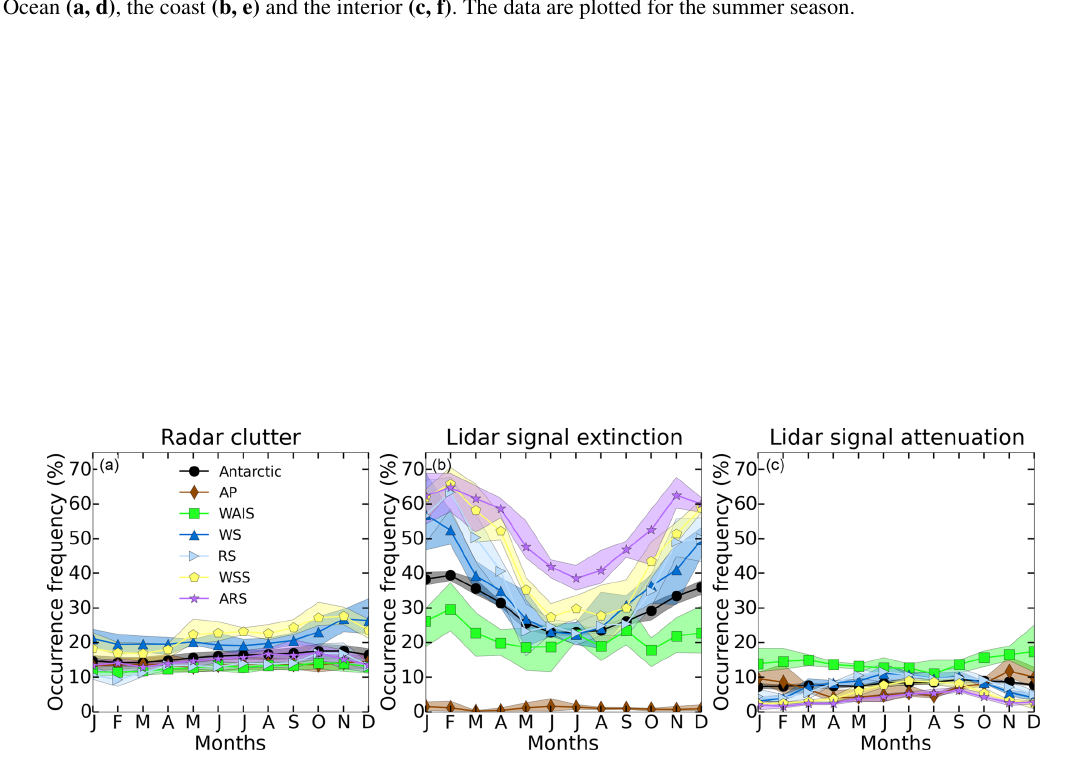
Figure A2. Monthly time series of the low-level occurrences of the radar clutter (a) , the lidar extinctions (b) and the lidar attenuations (c) for the areas defined in Fig. 4c and averaged over 2007–2010. The shaded areas correspond to the interannual